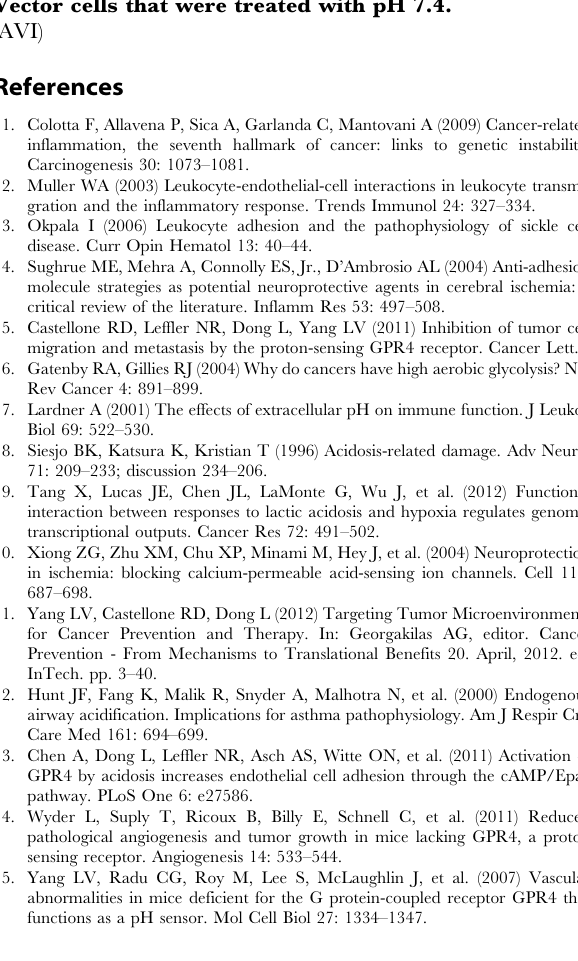
Video S3 Adhesion of U937 monocytes to HUVEC/ Vector cells that were treated with pH 6.4. (AVI) Video S4 Adhesion of U937 monocytes to HUVEC/ GPR4 cells that were treated with pH 8.4. (AVI) Video S5 Adhesion of U937 monocytes to HUVEC/ GPR4 cells that were treated with pH 7.4. (AVI) Video S6 Adhesion of U937 monocytes to HUVEC/ GPR4 cells that were treated with pH 6.4.